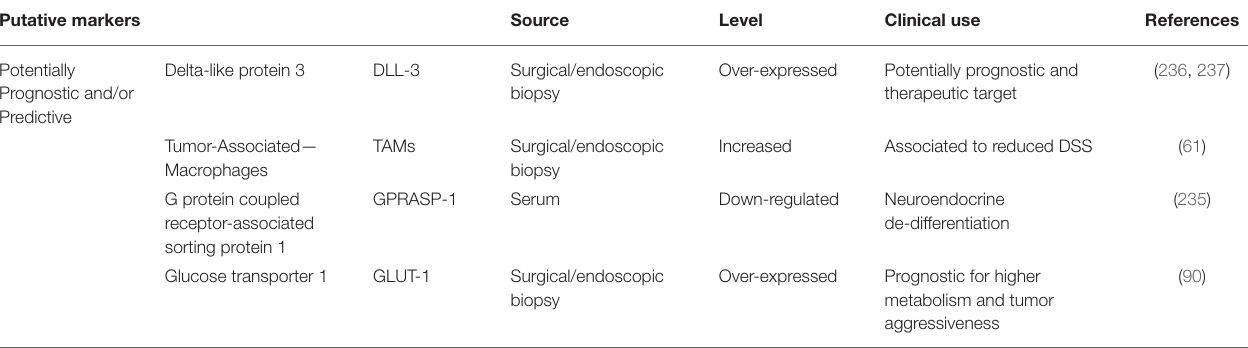
TABLE 5 | Novel potential biomarkers for PanNENs diagnosis, prognosis and treatment monitoring. Putative